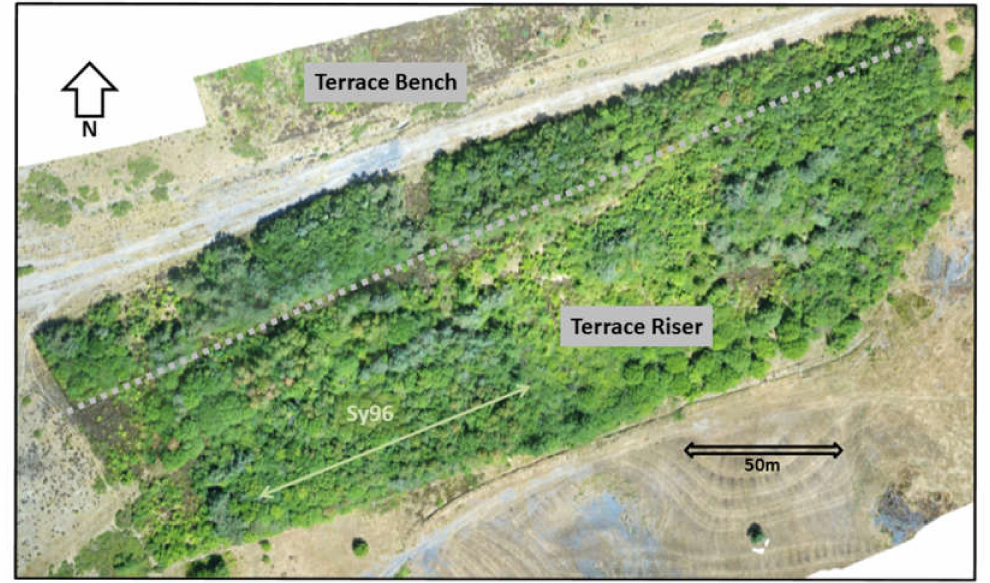
Figure 2. Orthophotomosaic of part of Varteg test plot area (Ben Sansom, July 2018). Prior to industrialization, the site for this study was Upland Oak woodland. Hence, Oak has been inter-planted among the Alders as a legacy crop. Once again, although purchased as “Welsh (Durmast) Oak”, this proved to include a range of types on the spectrum between Welsh Oak and English Oak ( Quercus petraea (Matt.) Liebl., Quercus robur L. and hybrids). The planting mix was supplemented with Scots Pine ( Pinus sylvestris ,